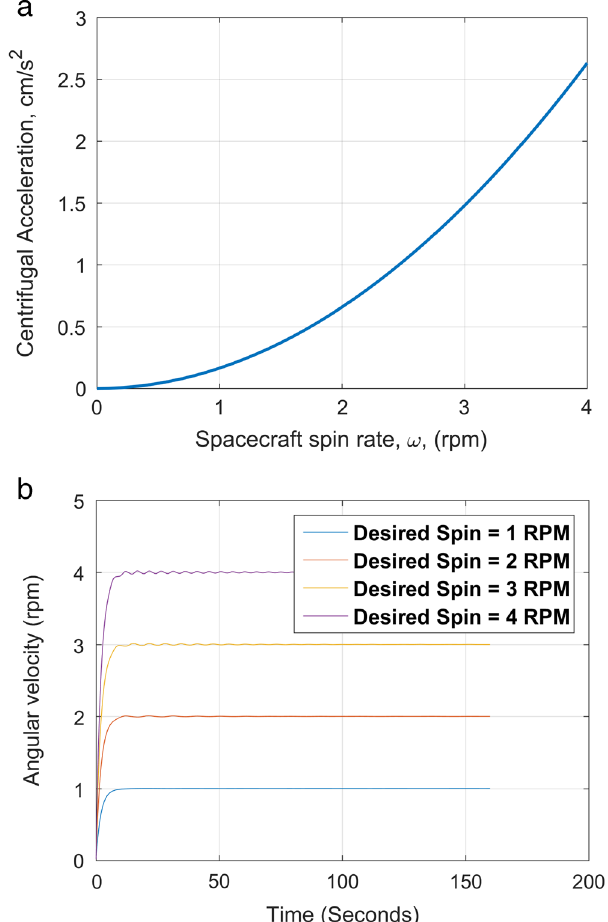
Fig. 3 Dynamical stability of AOSAT-1. a Centrifugal acceleration (arti fi cial milligravity) calculated as a function of angular velocity inside a 3U con fi guration, 43 assuming r = 20 cm. b Calculated spin- up of AOSAT-1 using a single reaction wheel creates a wobble stabilized by magnetorquers, assuming a worst-case regolith distribution. Stable 1 r.p.m. rotation (2 × 10 − 4 g ) is obtained from a nonrotating state after 15 s, and 4 r.p.m. (3 × 10 − 3 g ) after ~100 s